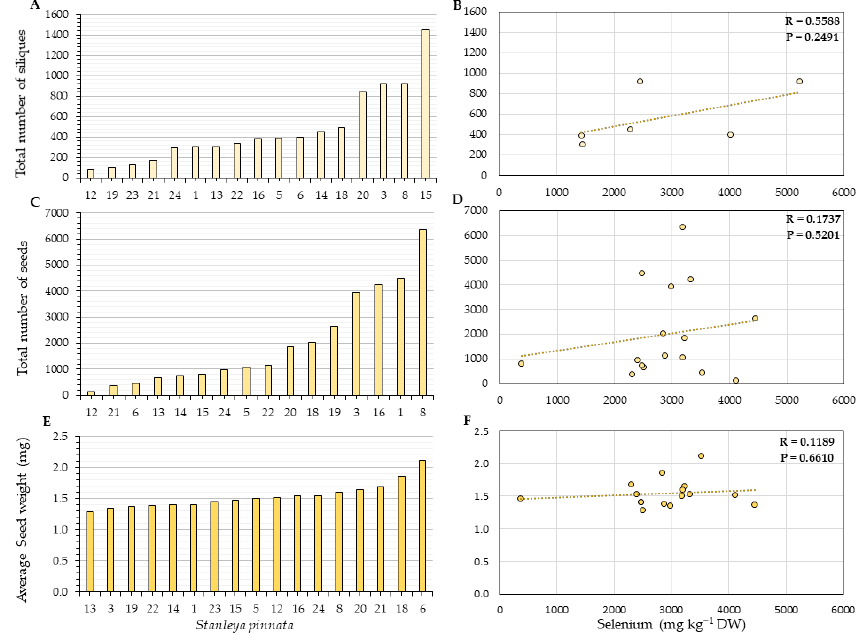
Figure 7. Reproductive fitness parameters ( A , C , E ) and their correlation with silique ( B ) or seed ( D , F ) Se concentration for S. pinnata plants growing at Pine Ridge. ( A , B ) Total number of siliques per plant, ( C , D ) total number of seeds per plant, and ( E , F ) average seed weight. The numbers on the horizontal axis ( A , C , E ) represent the collection numbers for individual plants at the locations indicated in Figure 3. The graphs show the correlation coefficient R and p -value for panels ( B , D , F ).